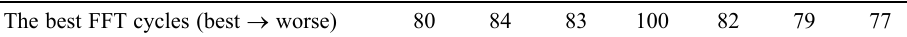
Table 1. Best FFT cycles (number of days in one period) The best FFT cycles (best → worse)